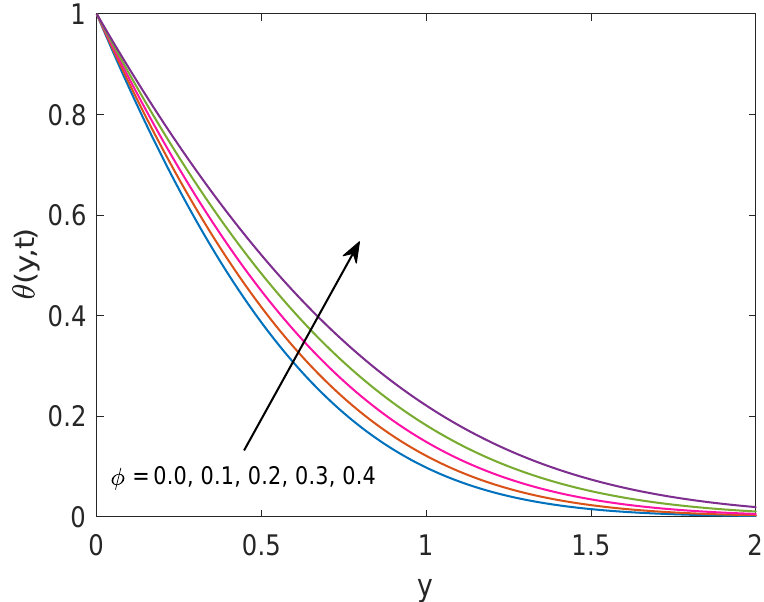
Figure 14. Temperature profile for different φ when Pr = 6.2, Nr = 1.5, Q = 0.5 and t = 0.5.